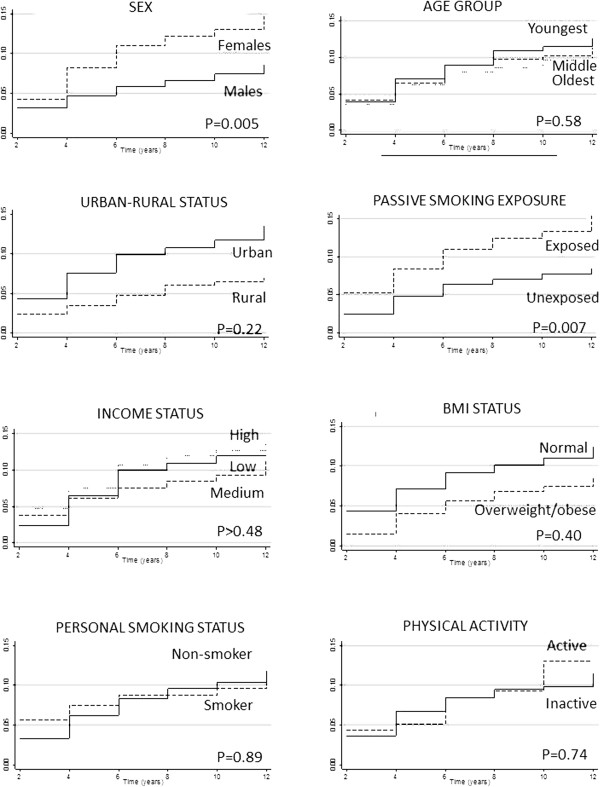
Cumulative hazard curves for each independent variable of interest. Solid line – The reference group (with the exception of urban–rural). Dashed line – Comparison group 1. Dotted line – Comparison group 2 (where appropriate).